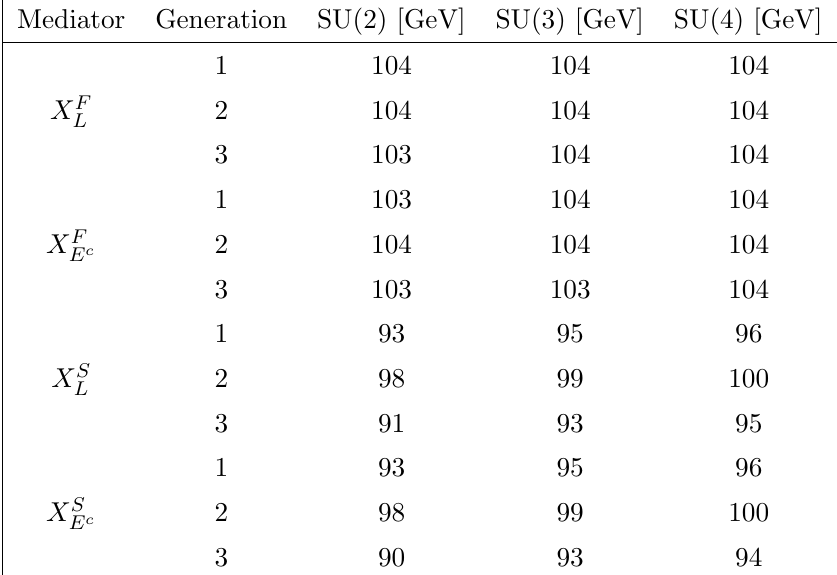
troweakly produced. Lepton colliders do not share this problematic and represent probably the best opportunity to discover mediators of category II for small r